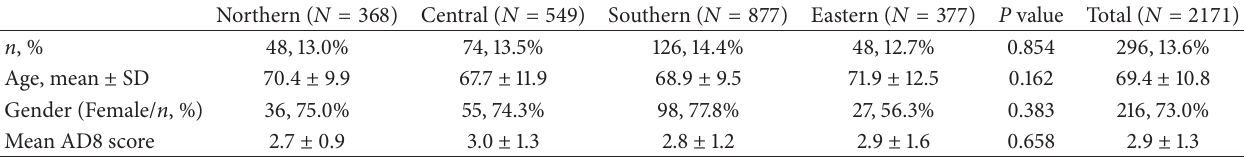
Table 2: Demographic characteristic of participants suspected dementia ∗ .